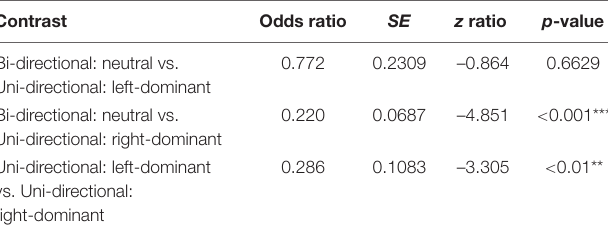
TABLE 5 | Pairwise comparisons of merged simplicity and